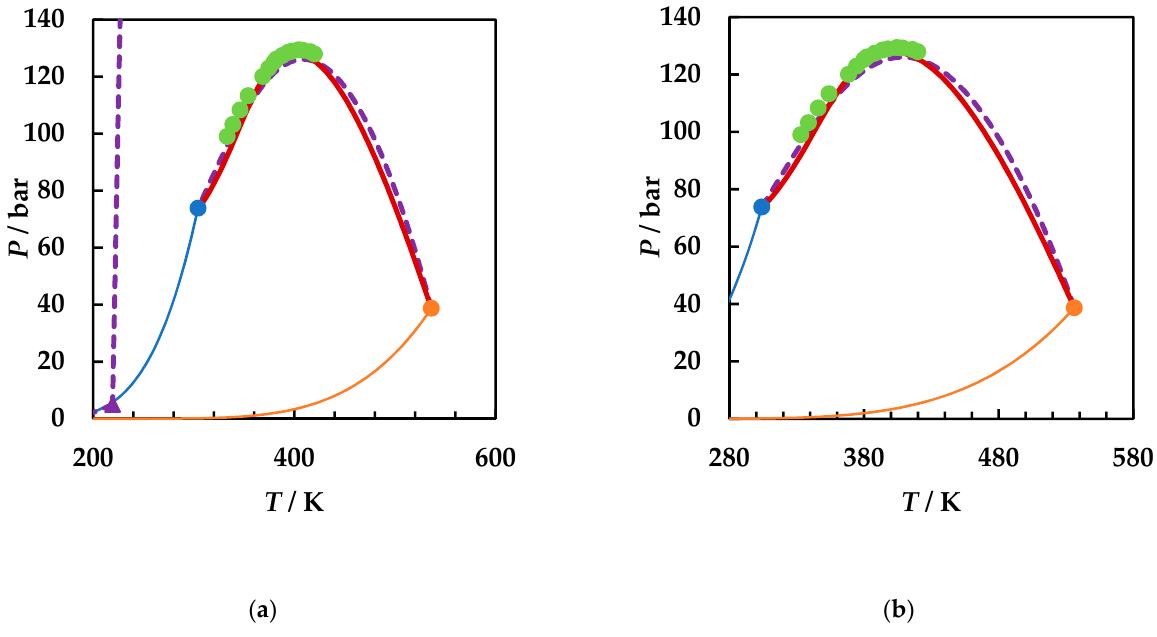
Figure 4. P – T fluid phase diagrams for carbon dioxide (1) + ethyl acetate (2) binary system. ●, [51]; ○ , [50]; ●, ●, critical points of CO 2 , EA [33]; ─ , ─ , vapor pressures of pure components; ▬ , GEOS predictions; ▲ (UCEP) , - - - , PR predictions.